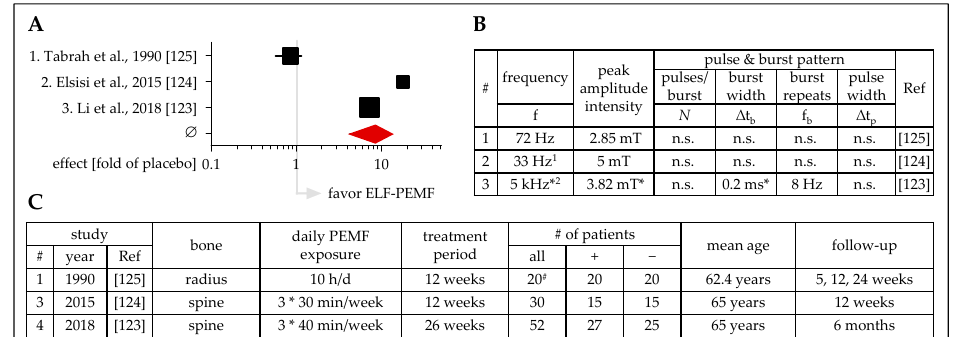
Figure 6. Clinical studies (prospective, placebo-controlled, blinded) investigating the effect of ELF-PEMF treatment on osteoporosis. ( A ) Forest plot showing ELF-PEMF effects fold of placebo ± 95% C.I.—sum was calculated as described by Neyeloff et al. [107], with weighting based on sample size. ( B ) Tabular overview of the ELF-PEMF used in the presented studies. ( C ) Tabular overview of the presented studies including affected bones, basic information on the treatment and follow up, as well as the number of patients investigated. 1 Automatic PMT Quattro Pro, ASA magnetic field, Arcugnano, Italy; 2 XT-2000B therapeutic stimulator, Tianjin xtmed, Tianjin, China; f: frequency; ∆ t b : burst width; f b : burst repeats; ∆ t p : pulse width; # left-right comparison; + ELF-PEMF treatment; − placebo treatment; n.s.: not specified; * obtained from a secondary source.